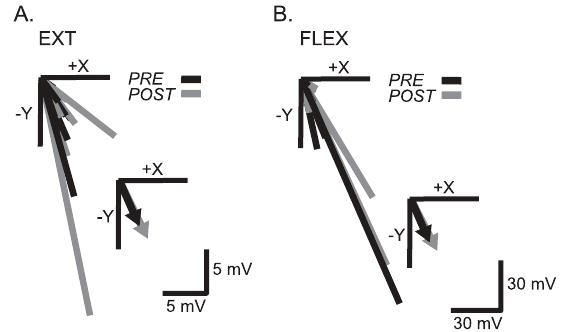
from the peak Fx (+x) and Fy (-y) magnitudes (posterior-lateral direction) pre-post practice within either condition, or between EXT and FLEX conditions (Figure 5).